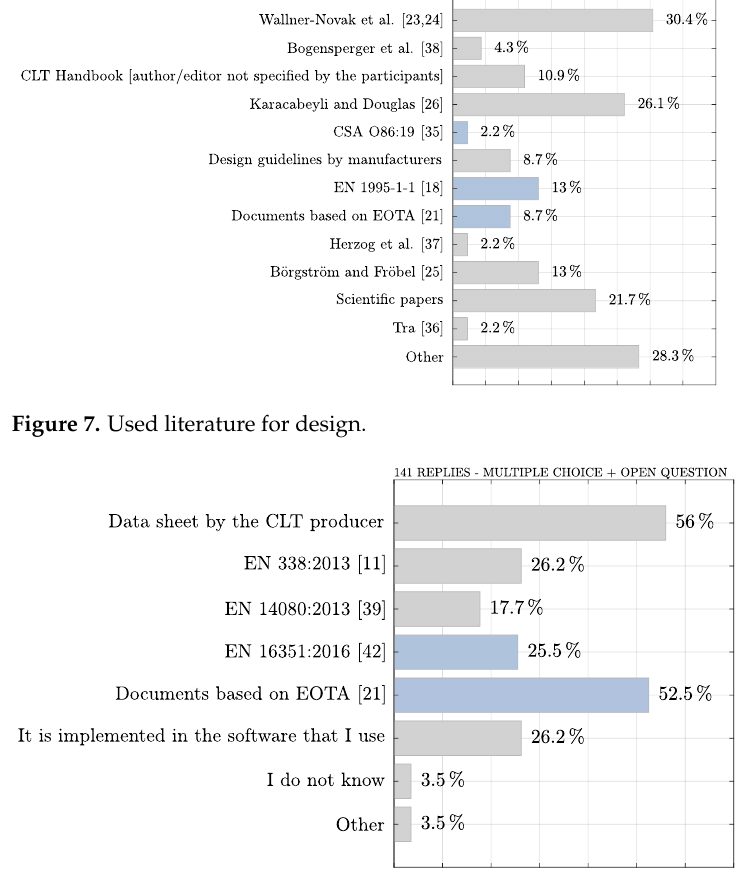
Figure 8. Used literature for product